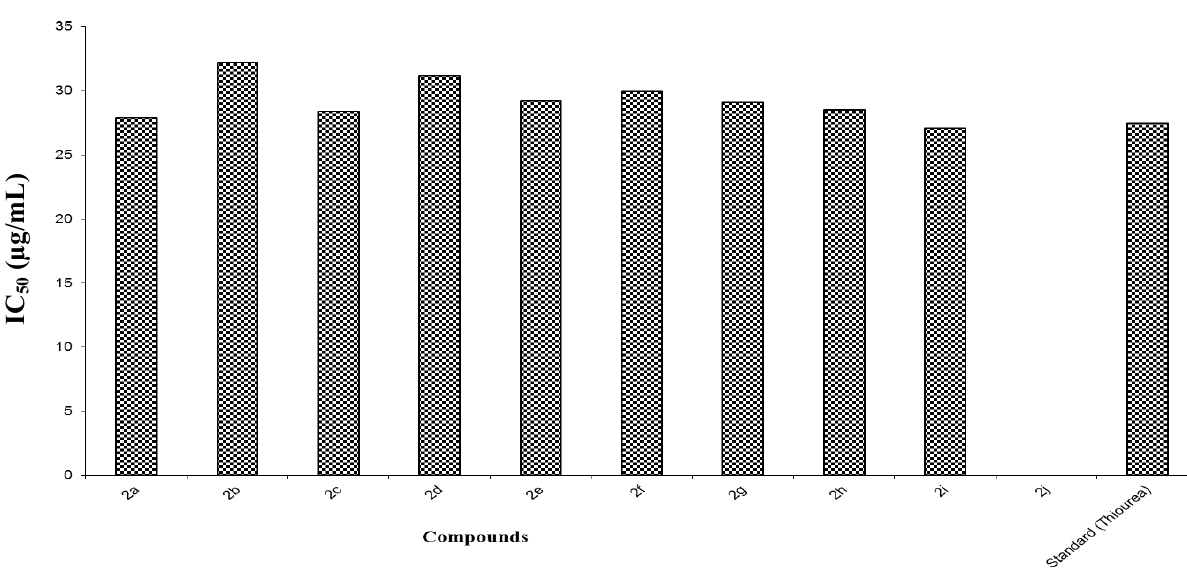
Figure 2. IC values of anti-urease 50